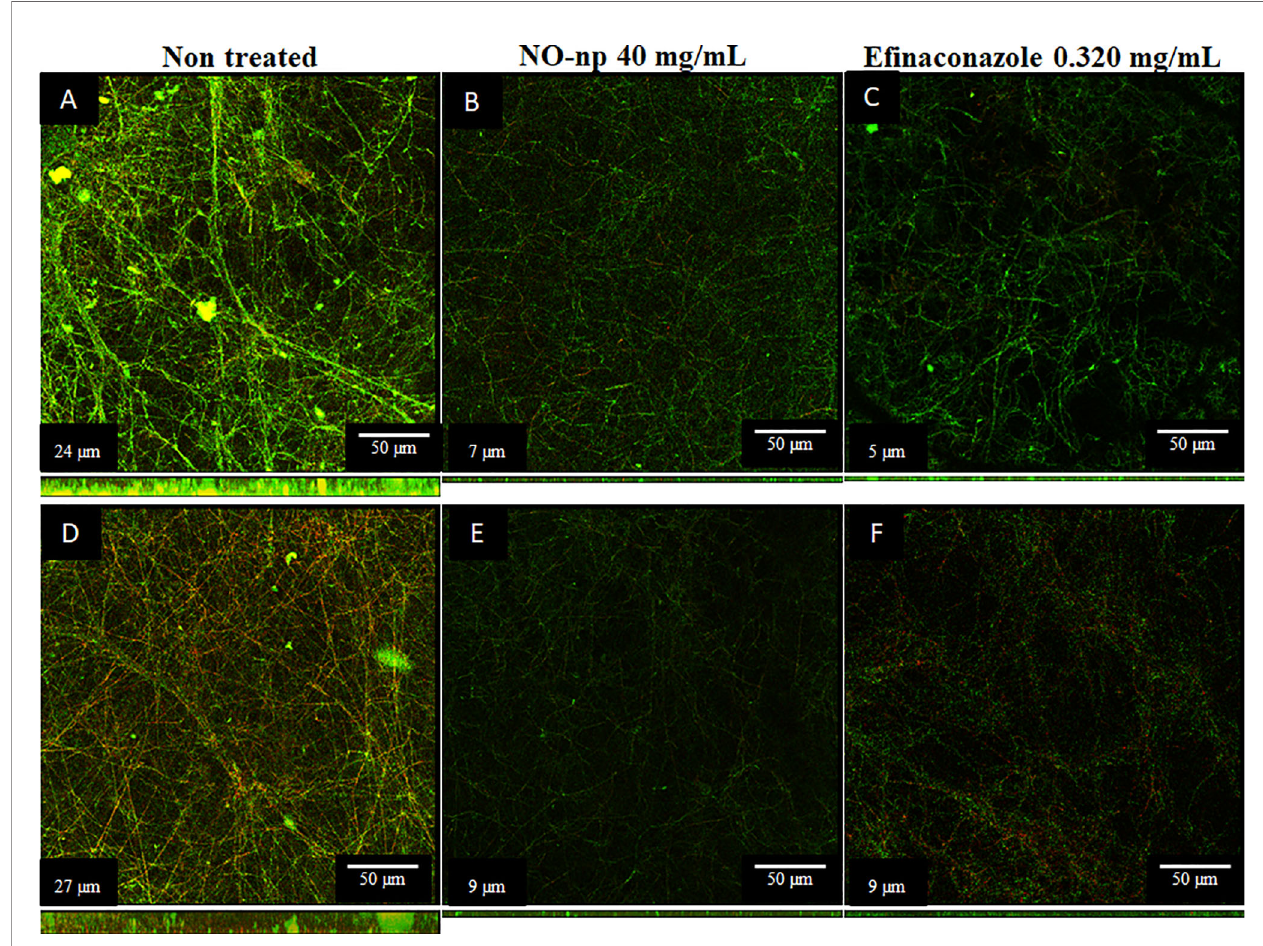
FIGURE 3 | Confocal microscopy images of mature T. rubrum bio fi lms formed on glass-bottom plates for 72 h at 37°C (A, D) and treated with NO-np (B, E) or EFCZ (C, F) . Orthogonal images of mature T. rubrum bio fi lms showed metabolically active (red, FUN-1-stained) cells embedded in the polysaccharide extracellular material (green, ConA), while the yellow-brownish areas represent metabolically inactive or nonviable cells. Images were obtained after 72 h of exposure of the fungal cells to 40 mg/mL of NO-np or 0.32 mg/mL of EFCZ, and the images were compared with those of bio fi lms incubated in presence of RPMI. The pictures were taken at a magni fi cation of ×63. Bars, 50 m m. The thickness of the fungal bio fi lms grown under these conditions was measured by z -stack reconstruction. The results are representative of those of two